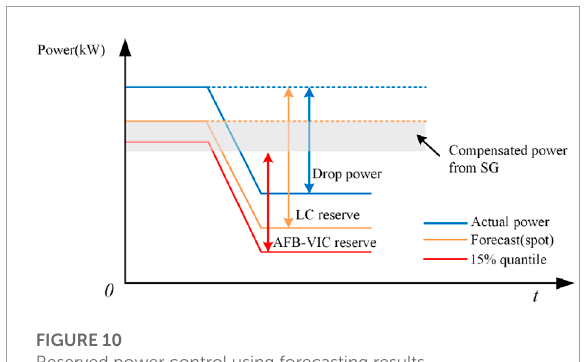
FIGURE 10 Reserved power control using forecasting